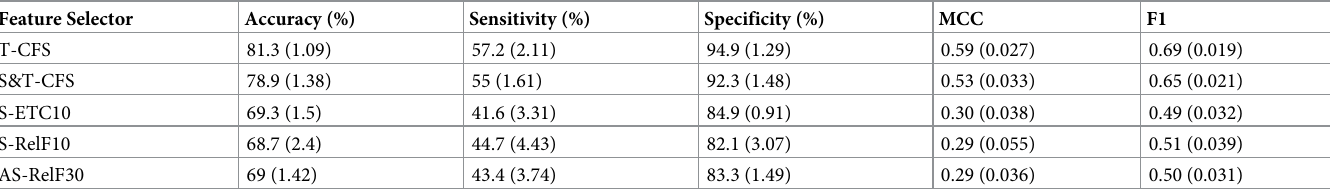
Table 6. Final mean and standard deviation (in brackets) metrics for optimized models based on 10 random